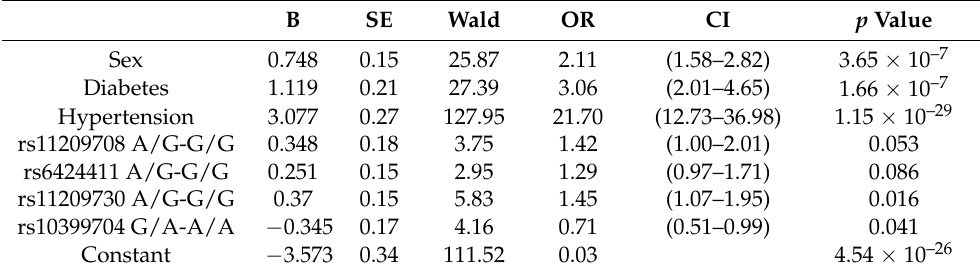
Table 3. Multivariate logistic regression model for the risk of